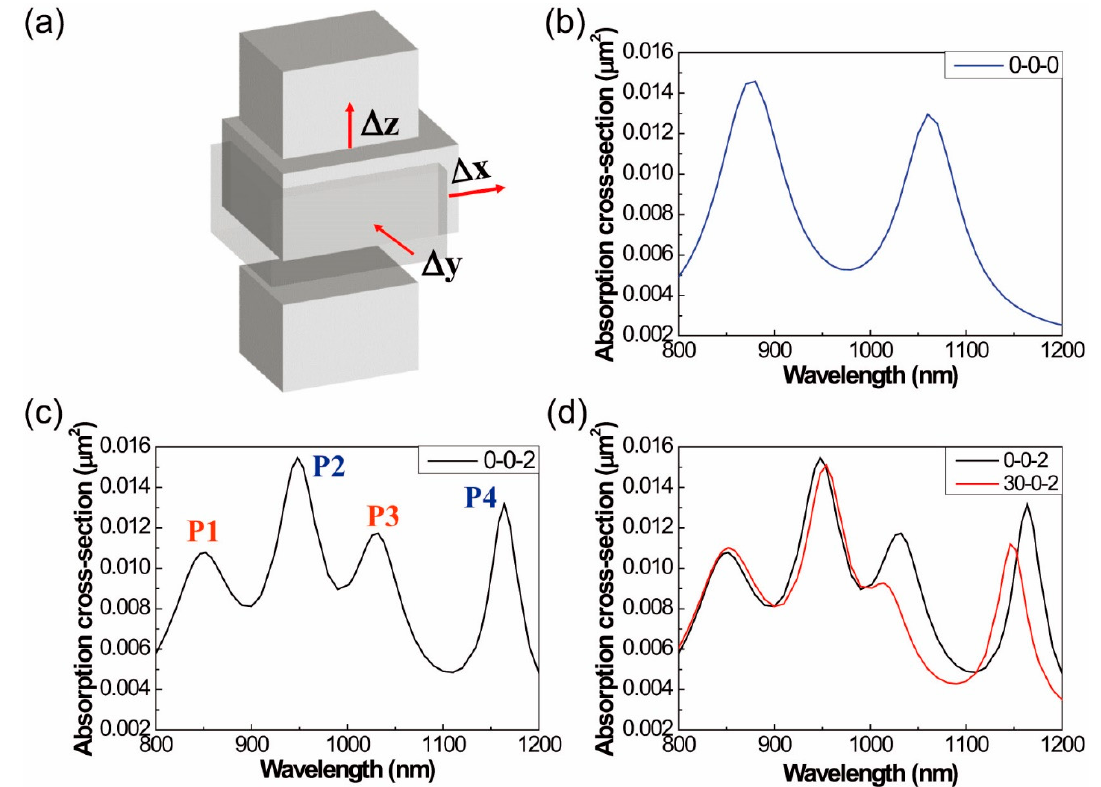
Figure 7. ( a ) A schematic diagram of a 3D plasmonic ruler. A central larger block moves freely in 3D space with a movement of Δ x (nm), Δ y (nm), and Δ z (nm). Upper and lower blocks have dimensions of 200 nm × 150 nm × 100 nm, and the central block has dimensions of 260 nm × 210 nm × 100 nm. Absorption cross-section spectra as functions of wavelength ( b ) without a movement of the central block, denoted by (0-0-0), and with a movement of the central block ( c ) only 2 nm along the z -direction (0-0-2) and ( d ) 30 and 2 nm along the x - and z -directions (30-0-2), respectively. P1 and P3 indicate the absorption peaks of mode 1 and mode 2, respectively, excited at the lower gap of 12 nm and P2 and P4 indicate the peaks of mode 1 and mode 2 at the upper gap of 8 nm.